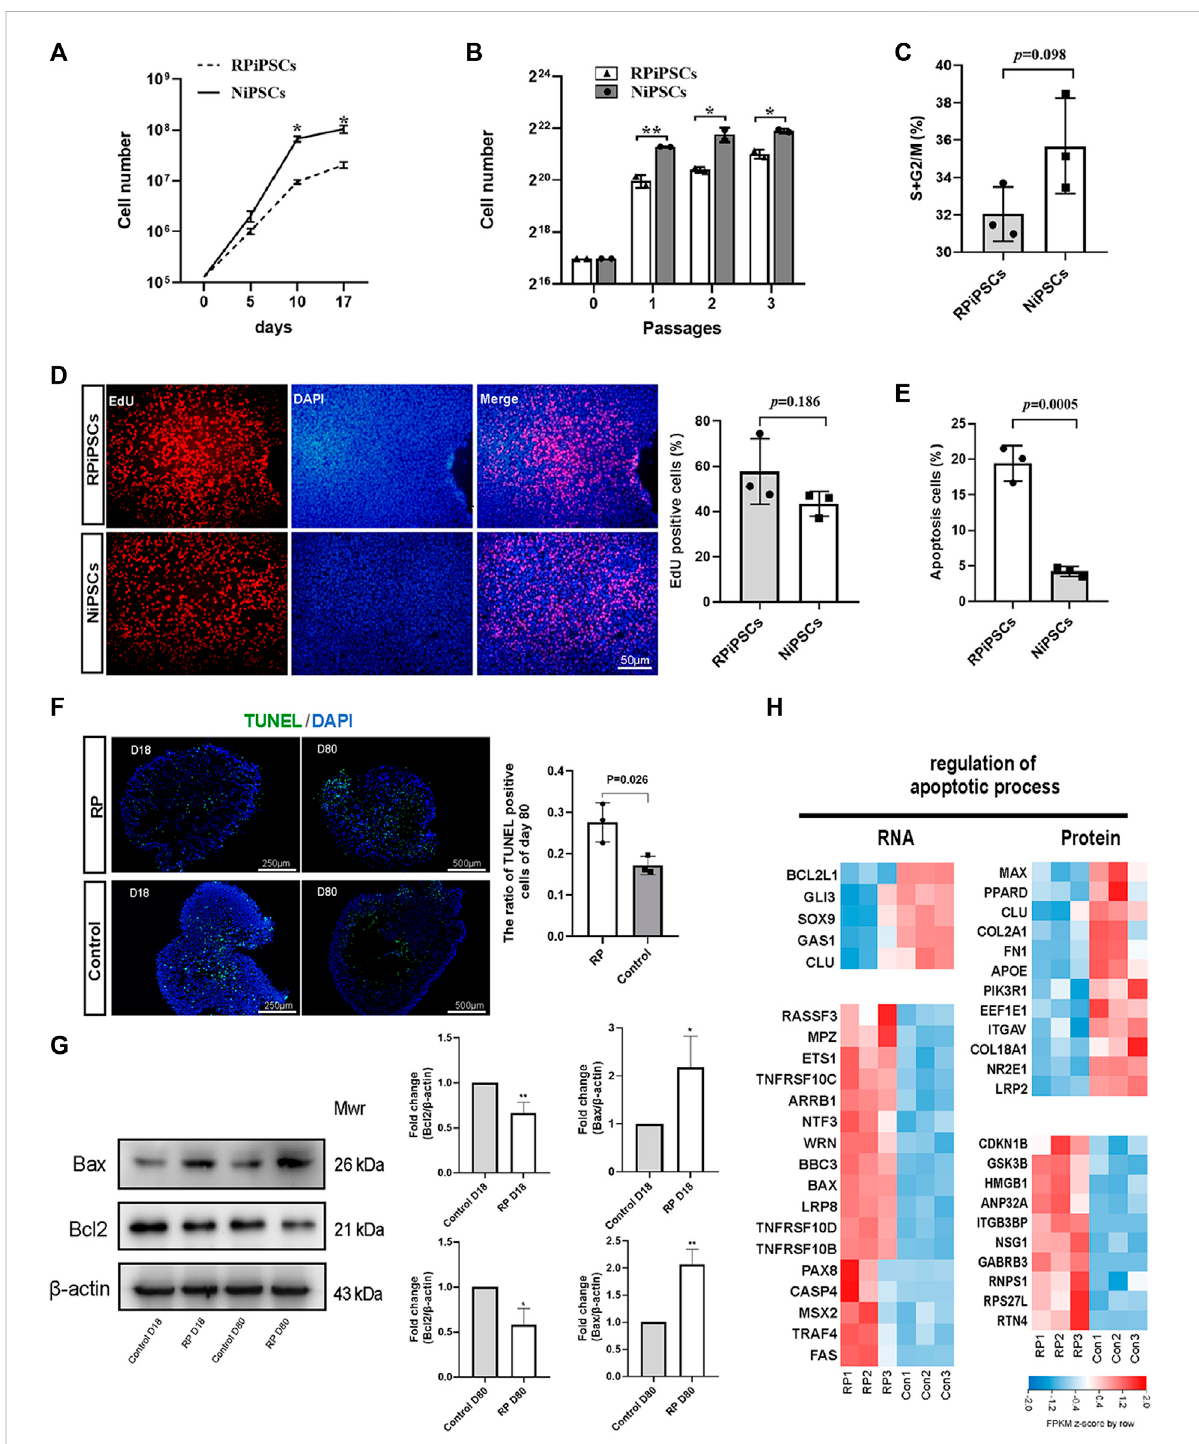
FIGURE 4 Increased apoptosisiniPSCsandROs withUSH2A variants (A,B) Cell numbers ofiPSCs atdifferentdays andpassages. (C) Cellcycledistribution analysis of two iPSC lines. (D) The percentage of EdU-positive cells in both iPSC lines. (E) Compared to control group, apoptosis rate of iPSCs signi fi cantly increased in theRP group. (F) Apoptotic cells were labeled with TUNEL (FITC, green). Nuclei are labeled with DAPI (blue) and the ratio of TUNEL-positive cellsin retina organoids in bothgroups atD80. (G) Western blottingresults ofbcl2 and baxatD18 and D80. The grayscale ratio of RP group to the control group quanti fi ed in bar graphs. Data are shown as mean ± SD. * p < 0.05, ** p < 0.01, *** p < 0.001 ( n = 3). (H) Heatmap of gene expression changes and proteins related to regulation of apoptotic process. Upregulated and downregulation expression are in red or blue respectively. Bar is representing Z-score. Con: